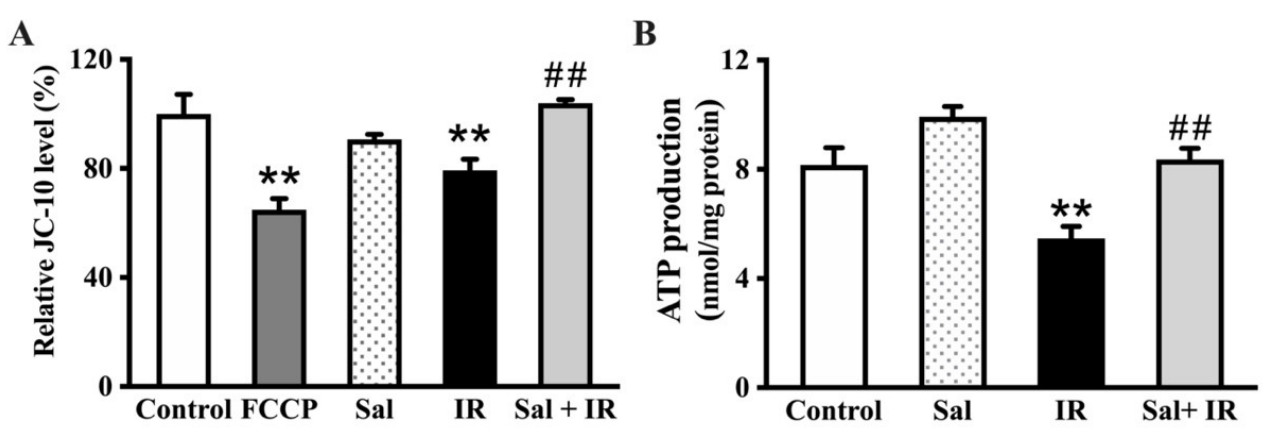
Figure 4. Salidroside maintained MMP and enhanced ATP in irradiated SMG cells. SMG-C6 cells were treated as described above in Figure 3. ( A ) MMP was detected using a JC-10 assay. FCCP was utilized as a positive control. ( B ) ATP levels were detected with an ATP assay kit. The data are displayed as the mean ± SEM from 3 independent experiments, with each sample analyzed in triplicate. ** p < 0.01 vs. the controls; ## p < 0.01 vs. the irradiation